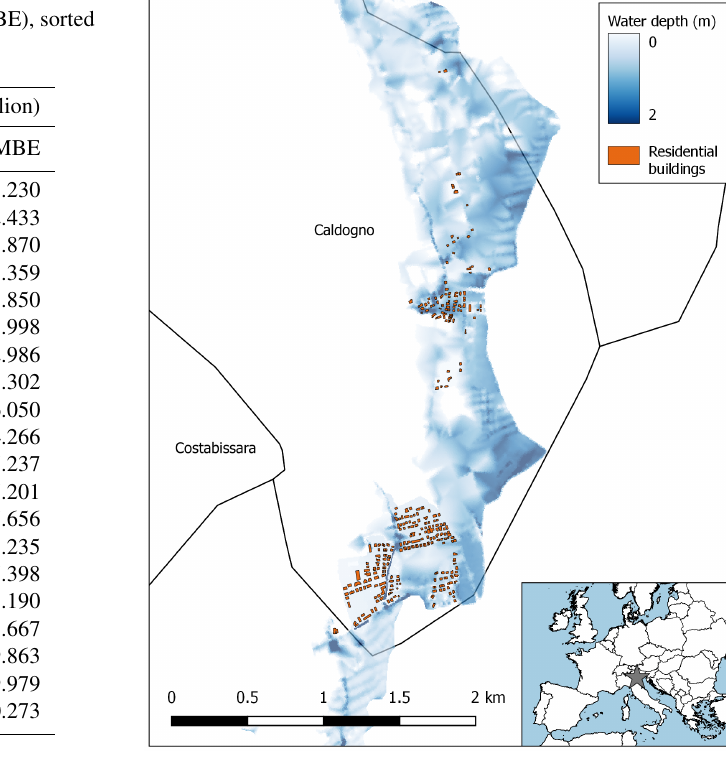
Figure 2. 2010 Bacchiglione river flood in Caldogno, Italy. The fig- ure shows the estimated flood extension and water depths (blue), and the location of the residential buildings considered in the study